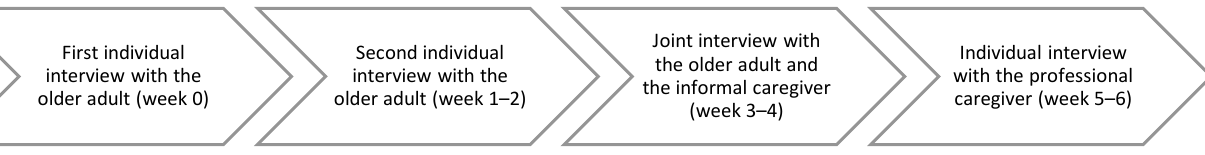
Figure 1. Data collection